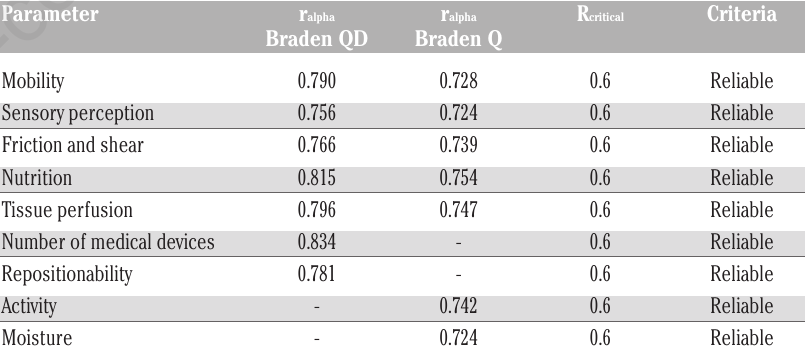
Table 3. The difference in reliability test results.